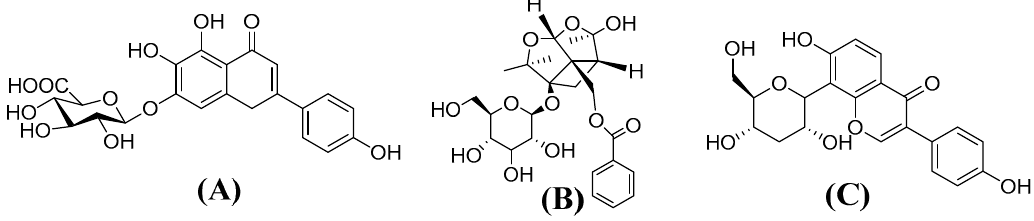
Figure 1. The structures of scutellarin ( A ); paeoniflorin ( B ); and puerarin ( C , IS).